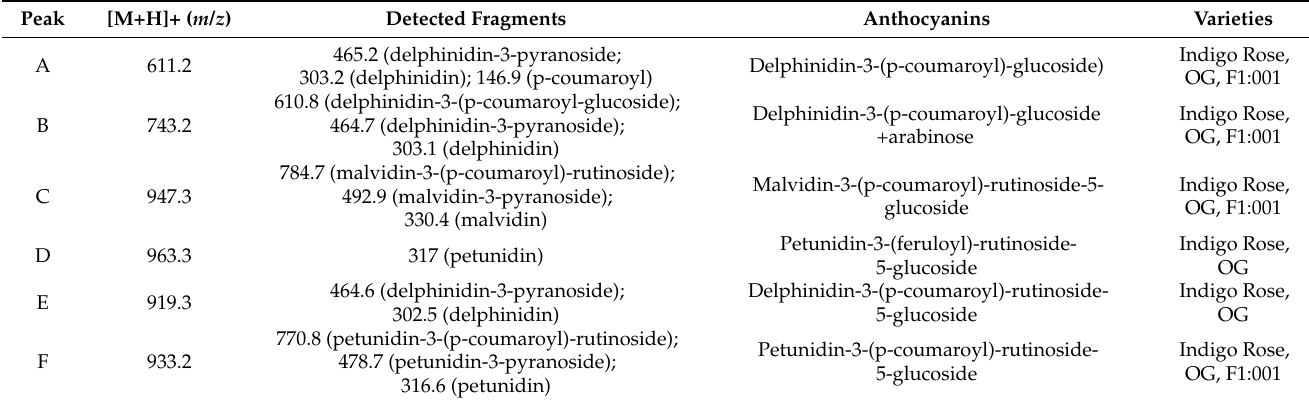
Figure 9. Chromatogram ( a ) and MS–MS fragments ( b ) of [M+H]+ ion with 933.2 m / z in three tomato varieties. Table 3. Anthocyanins found in three varieties of black cherry